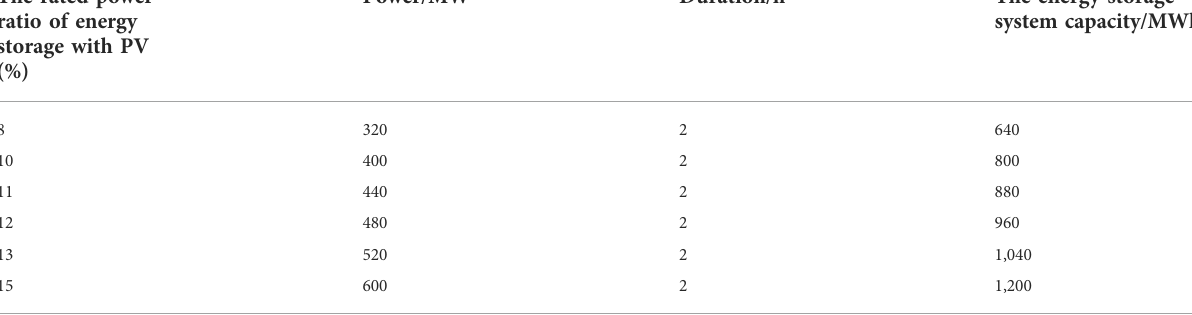
TABLE 1 Set value of energy storage power and capacity. The rated power ratio of energy